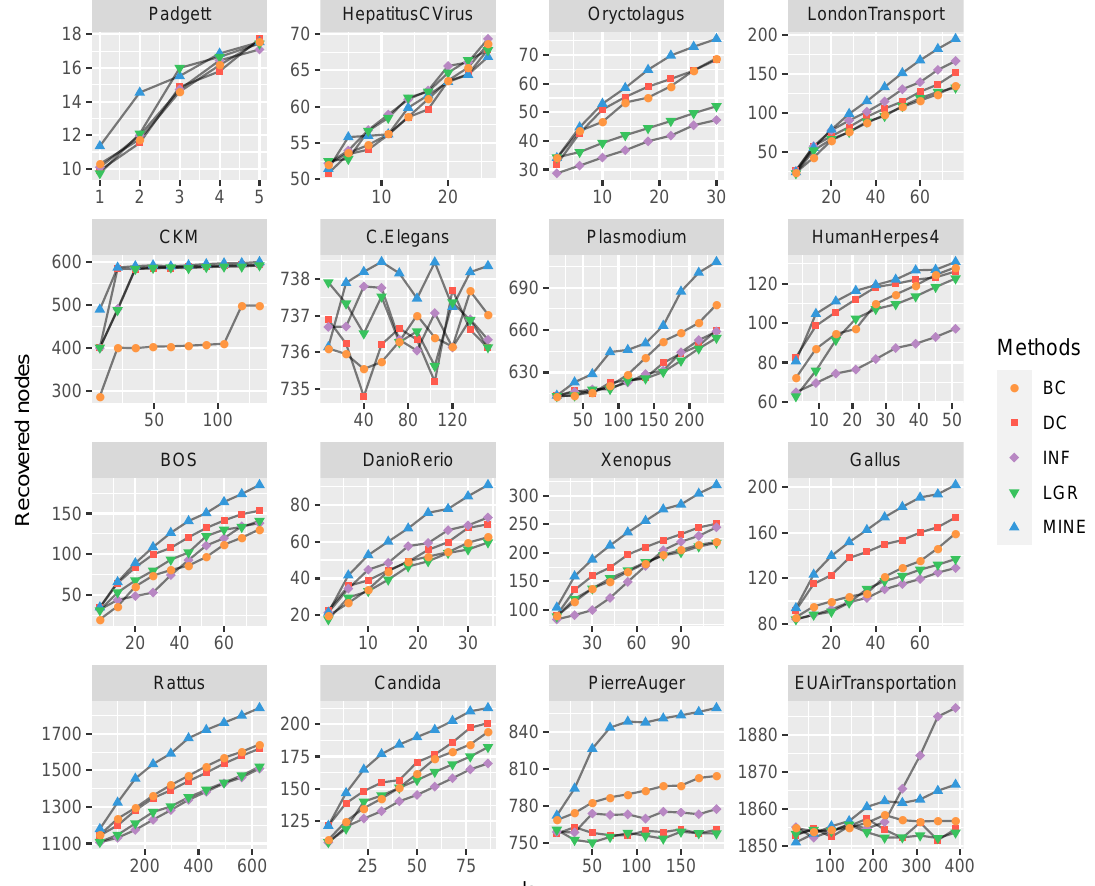
Figure 5. The comparison of recovered nodes with varying k (from 0 to 20 percent of total nodes) on 16 multilayer networks. The proposed MINE algorithm (marked with blue triangles) shows superiority to the competitors on BOS, Candida, C.Elegans, DanioRerio, Gallus, HumanHerpes4, LondonTransport, Oryctolagus, Plasmodium, PierreAuger, Rattus and Xenopus datasets, while on the EUAirTransportation dataset, the MINE algorithm is second to INF (marked with purple diamonds).